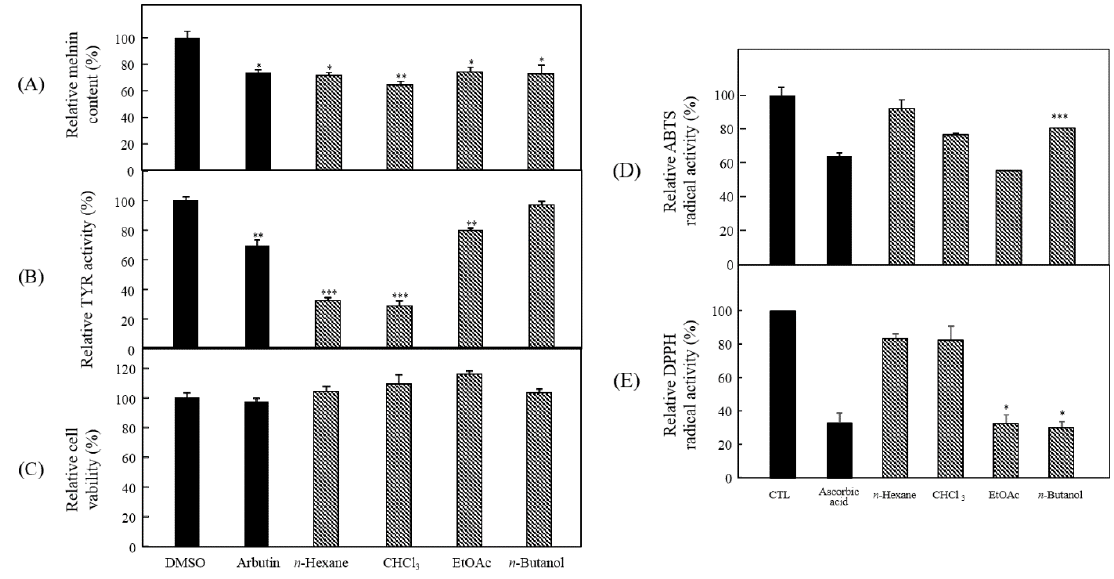
Figure 2. Anti-melanogenesis and antioxidant effects of each fraction of PAL. ( A ) Melanin content, ( B ) TYR activity ( C ) cytotoxicity in B16F10. ( D ) ABTS and (E) DPPH radical-scavenging activities. The data are expressed as the mean ± SD ( n = 3) of three individual experiments. * p < 0.05, ** p < 0.01 and *** p < 0.001, compared with control.